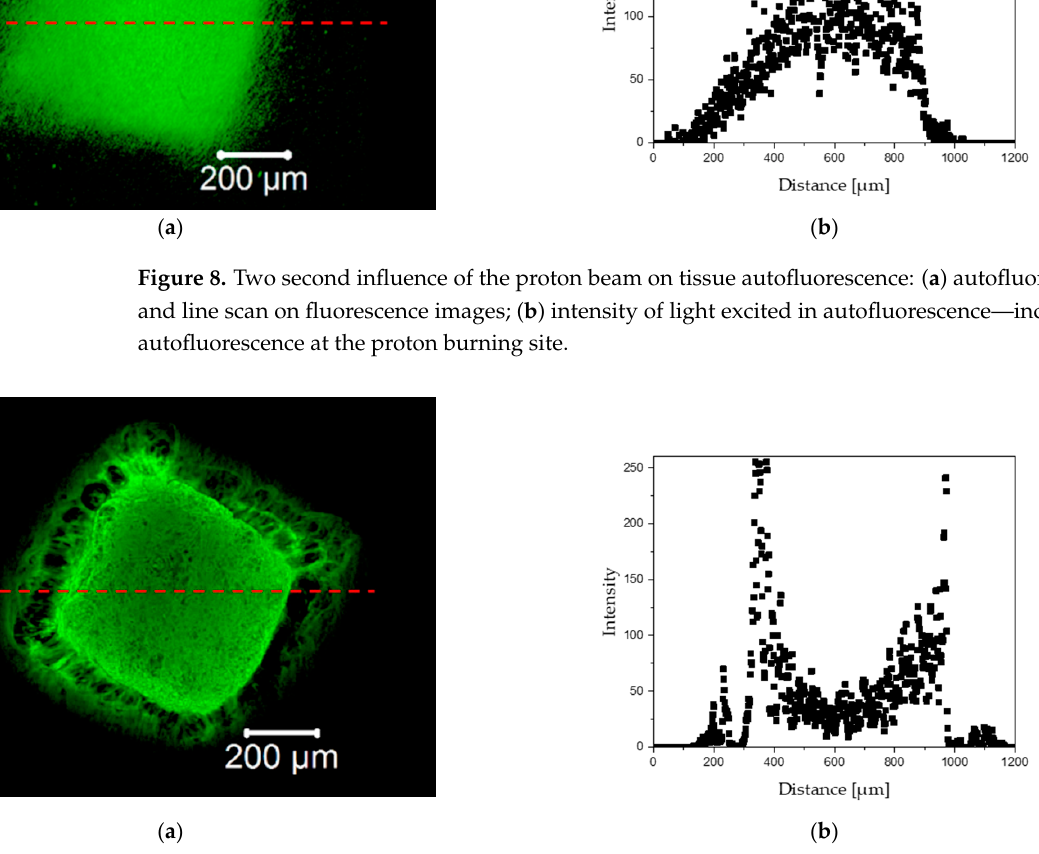
Figure 9. One-hundred-and-eighty second influence of the proton beam on tissue autofluorescence: ( a ) autofluorescence and line scan on fluorescence images; ( b ) intensity of light excited in autofluorescence—increase/decrease of autofluorescence at the proton over burning site.